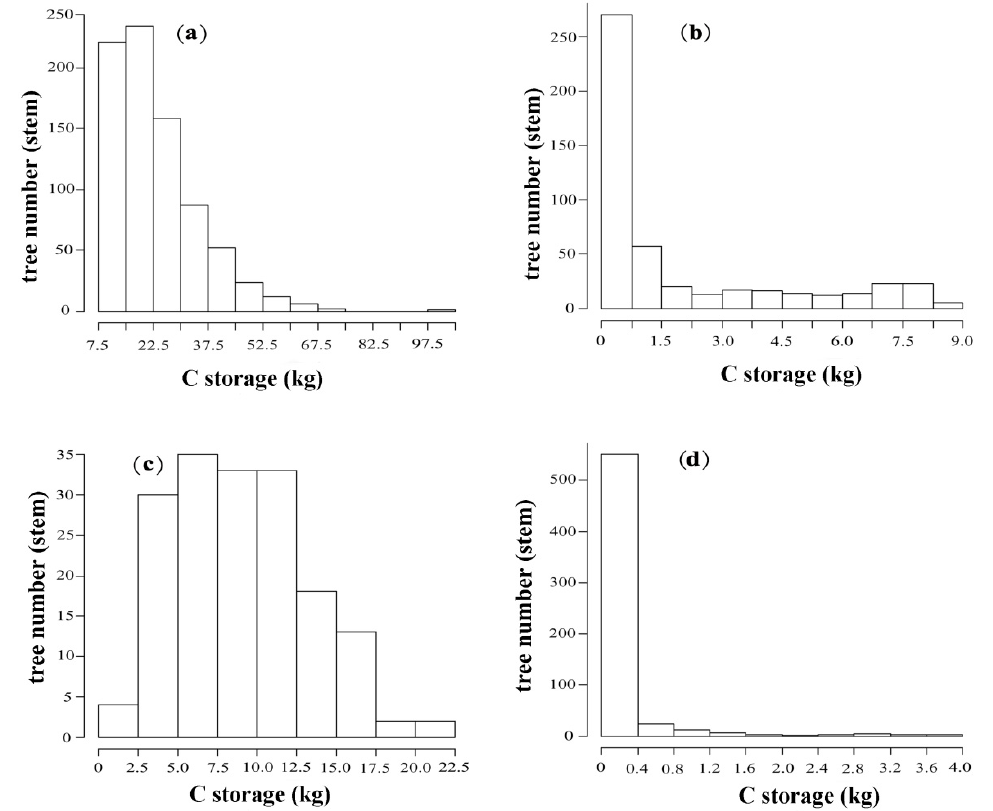
Figure 3. Histograms of biomass C class for each tree species in Pingshuo opencast coal mine, China. ( a ) Planted R. pseudoacacia ; ( b ) Seeded-in R. pseudoacacia ; ( c ) P. tabuliformis ; ( d ) U. pumila .